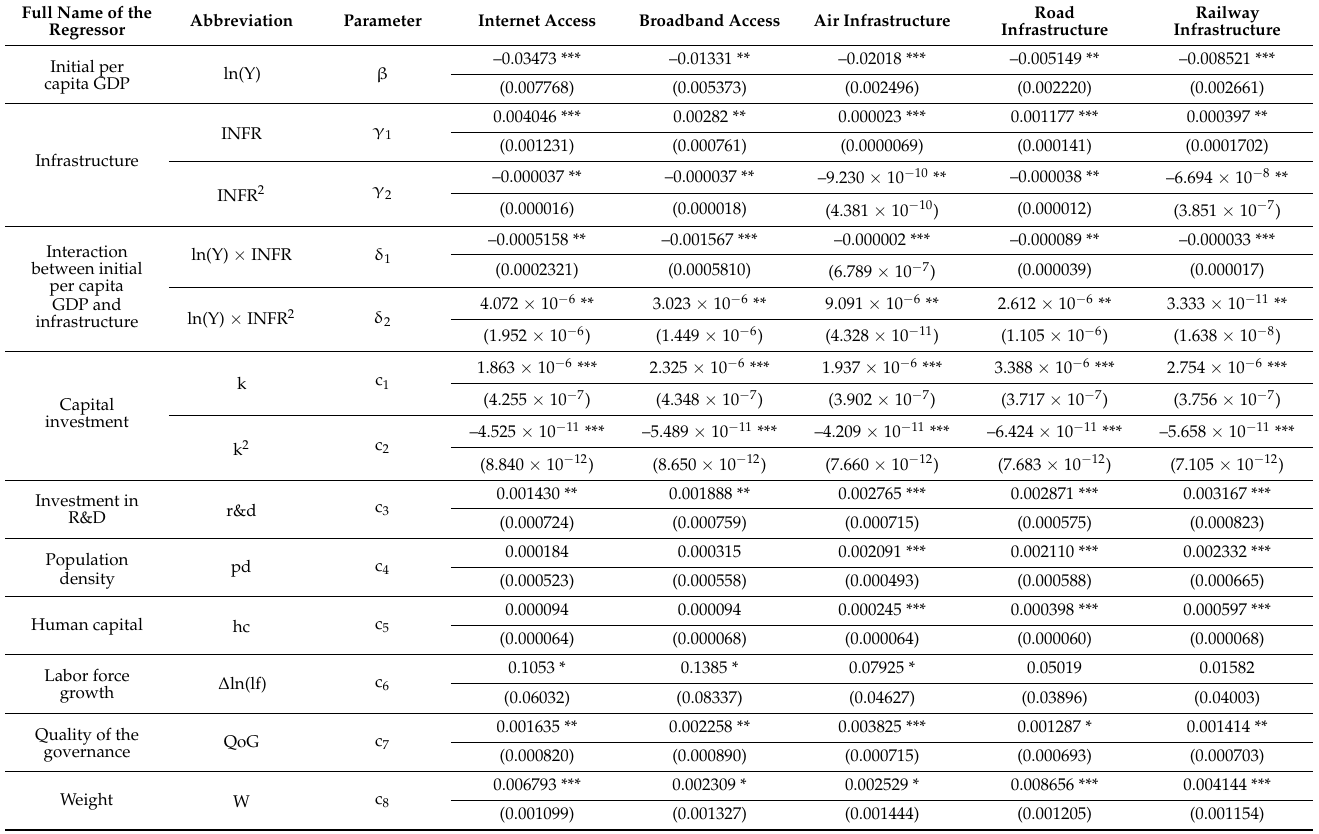
Table A1. Fixed effects estimates of Equation (2). Dependent variable—3-year forward-looking average growth